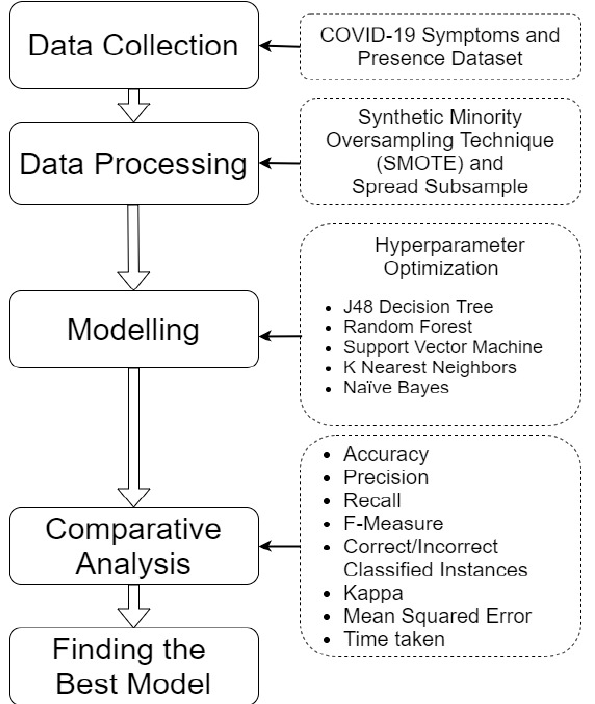
Figure 1. The five phases of this study are data collection, preprocessing, modelling, comparative analysis and finding the best model to determine COVID-19 presence. Table 2. Features, percentage level and attribute descriptions of the COVID-19 symptoms and presence